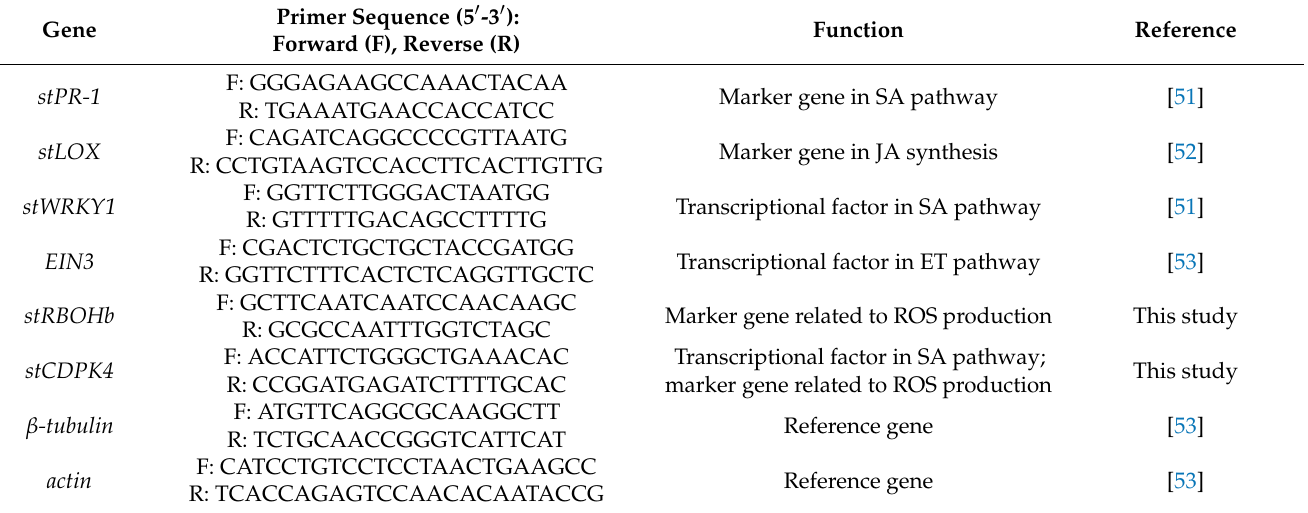
Table 1. Genes and their primer sequences for the analysis of gene expression using quantitative reverse transcription PCR (RT-qPCR).